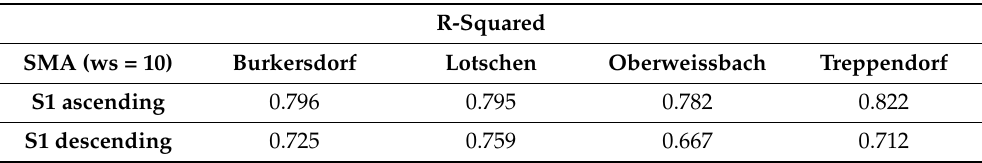
Table 2. Correlation coefficient (R 2 ) of in situ evapotranspiration (weather stations) and remotely sensed evapotranspiration (Terra/Aqua MODIS) for each AOI and both ascending and descending Sentinel-1 acquisition